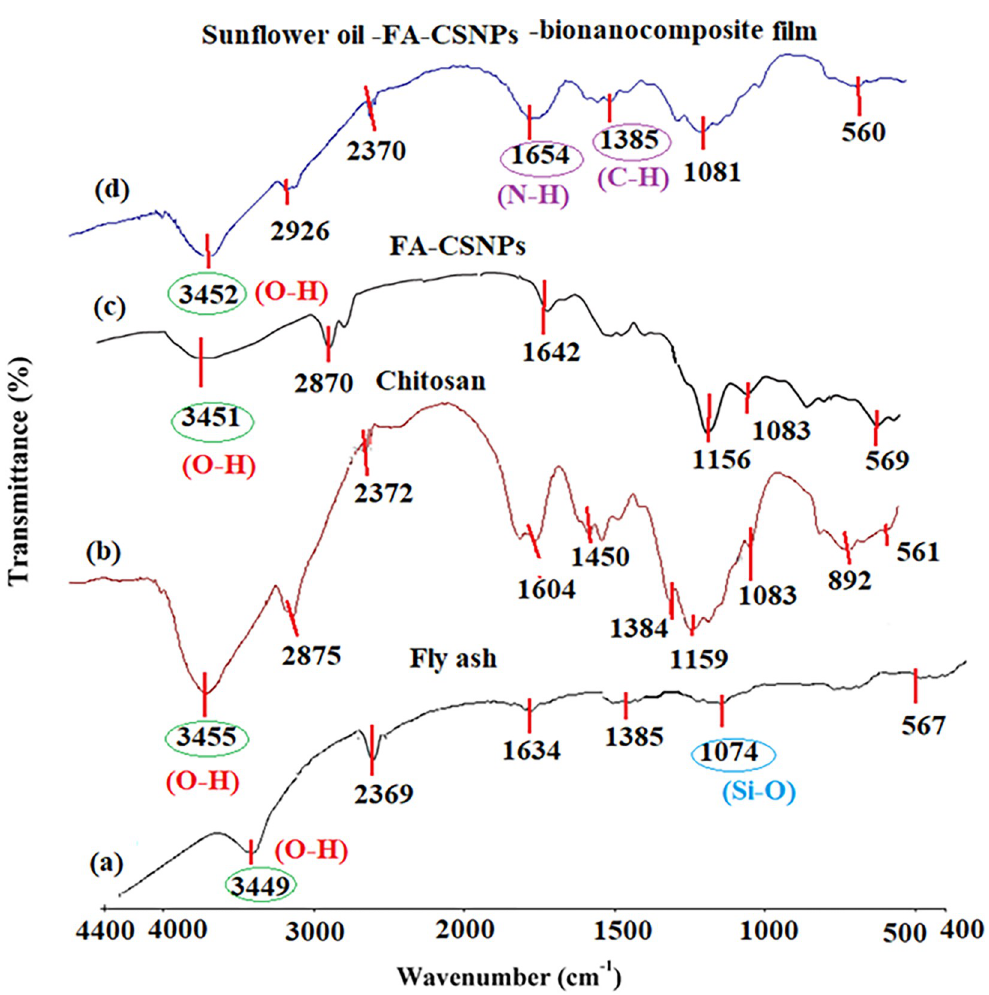
Fig 1. FTIR spectra of (a) Fly ash, (b) chitosan, (c) FA–CSNPs, and (d) Sunflower oil/FA–CSNPs–bionanocomposite film measured at wavenumber 4400–400 cm –1 using KBr pellets under 10 kg/cm 2 pressure for 50